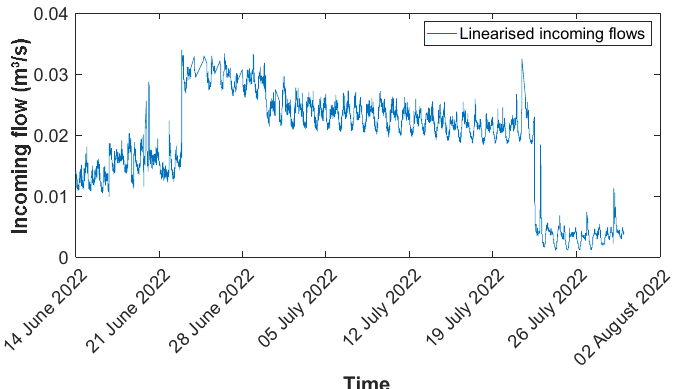
Figure 11. Calculated incoming flows at the start and end of a dry period with high initial infiltration (PS Zuidstraat).